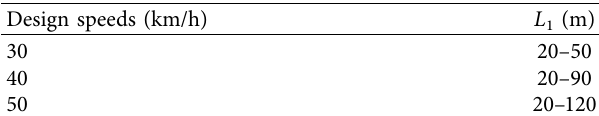
Table 2: The adjusted value of the prepositive